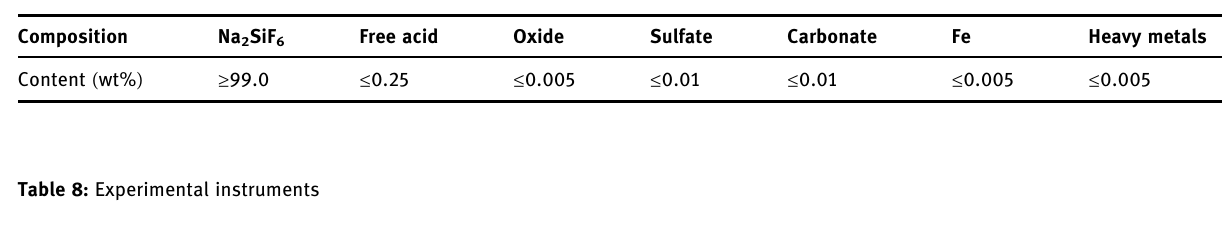
Table 7: Chemical composition of the sodium fl uorosilicate